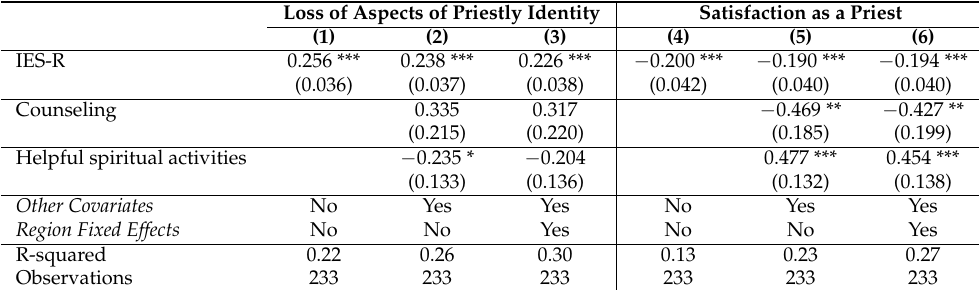
Table 4. COVID-19 distress, identity, and general satisfaction.